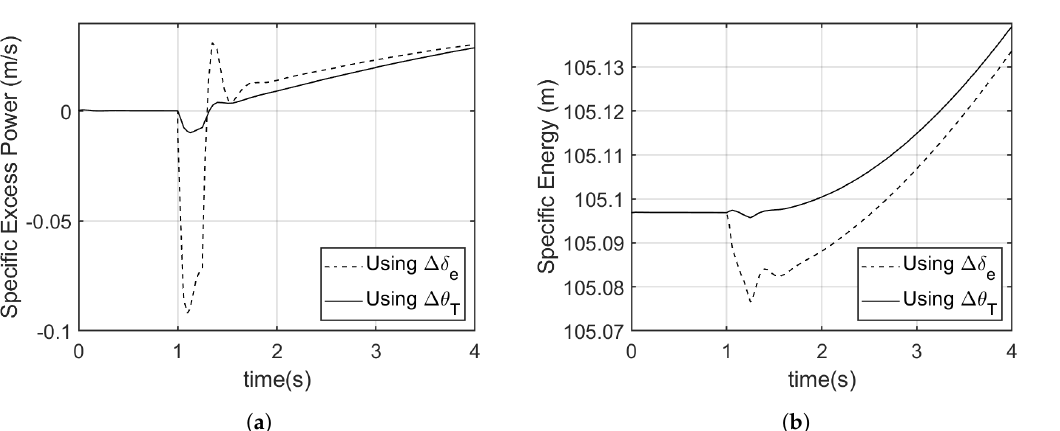
Figure 13. Model 2 aircraft pull up maneuver time response. ( a ) Specific excess power. ( b ) Specific